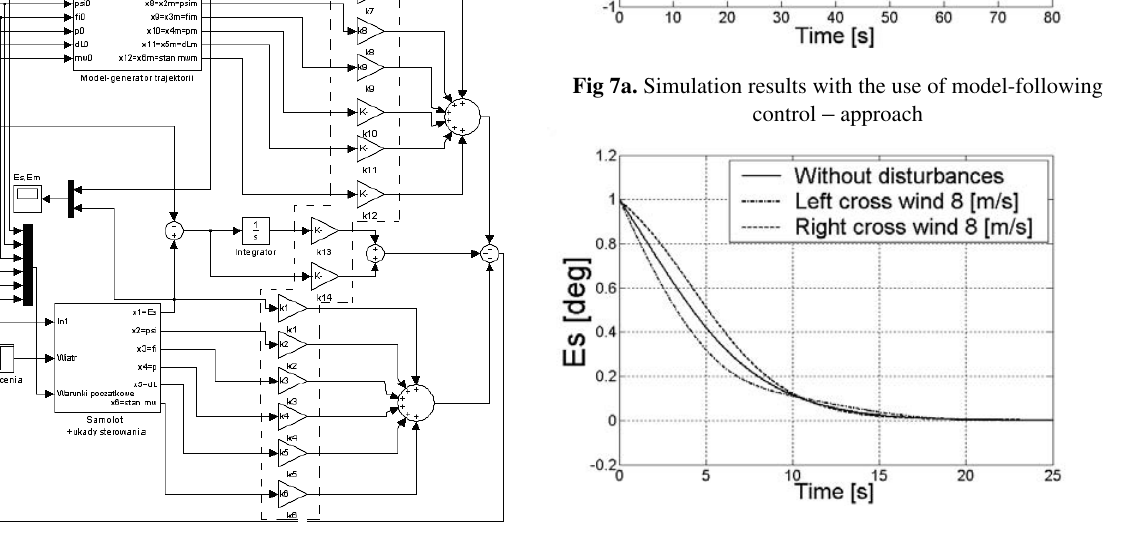
Fig 6. Simulation scheme for stabilization with the use of model-following control